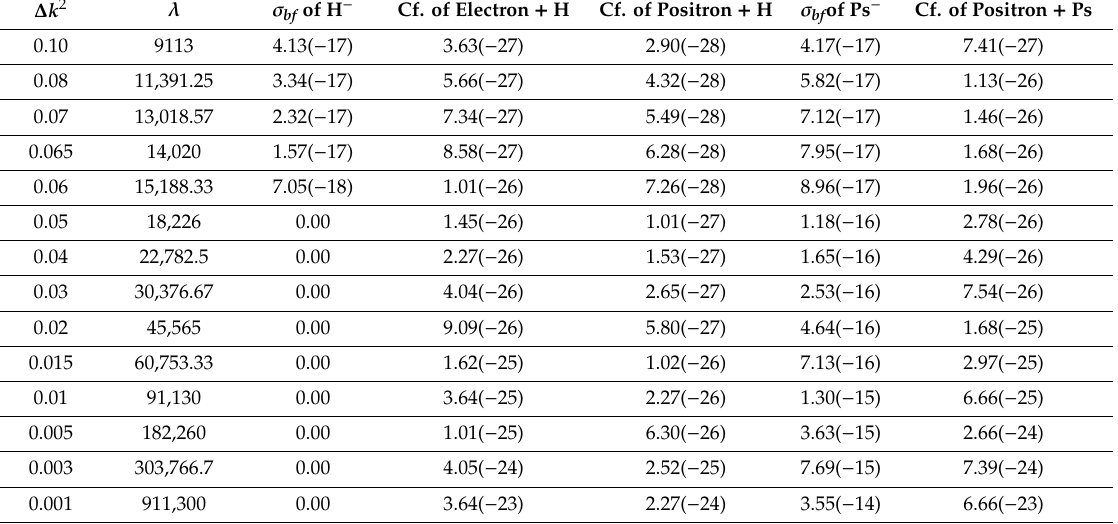
Table 25. Comparison of bound–free ( σ bf ) and free–free (Cf.) absorption coe ffi cients for electrons and positrons and hydrogen atoms at T = 6300